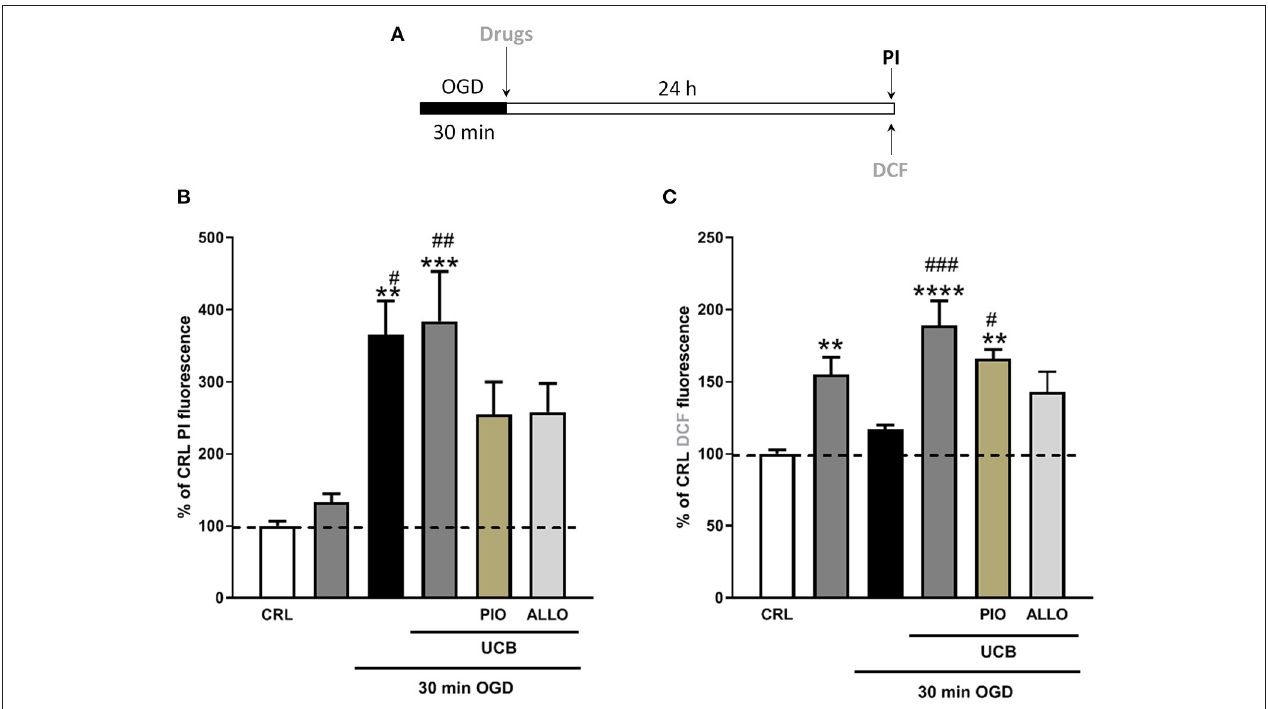
FIGURE 4 | Effects of pioglitazone and allopurinol on unconjugated bilirubin (UCB) induced-toxicity in OGD immature organotypic hippocampal slices. (A) Experimental protocol showing immaure hippocampal slices exposed to UCB (100 µ M) alone or plus pioglitazone and allopurinol (10 µ M) for 24h, immediately after 30min OGD. (B) Quantitative analysis shows that pioglitazone and allopurinol have a trend to decrease cellular death in UCB exposed OGD slices. (C) Differently, OGD did not increase cellular oxidative stress that was increased by UCB and decreased by allopurinol but not pioglitazone. Quantitative analysis of PI and DCFH2-DA fluorescence: Bars represent the mean ± SEM of at least seven experiments (about ≥ 48 slices for each experimental point). ** P < 0.05 vs. CRL; *** P < 0.01 vs. CRL; # P < 0.05 vs. UCB; ## P < 0.01 vs. OGD; **** < 0.001 vs CRL; ### < 0.01 vs OGD.